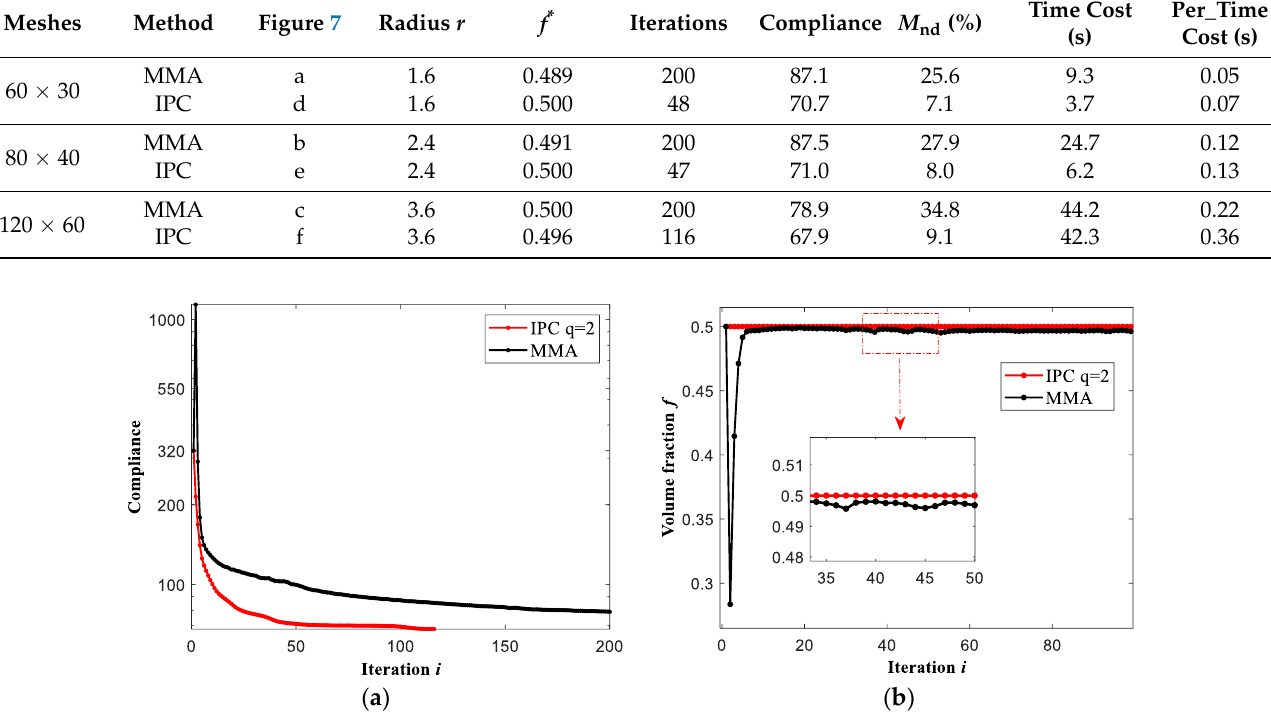
Figure 8. Convergence curves for the cantilever beam using MMA and IPC methods: ( a ) the changes in the compliance; ( b ) the changes in the volume fractions.